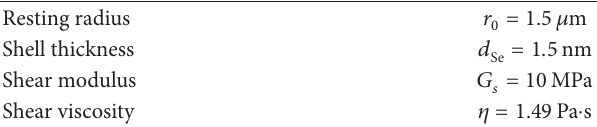
Table 1: The parameters of contrast agent. Resting